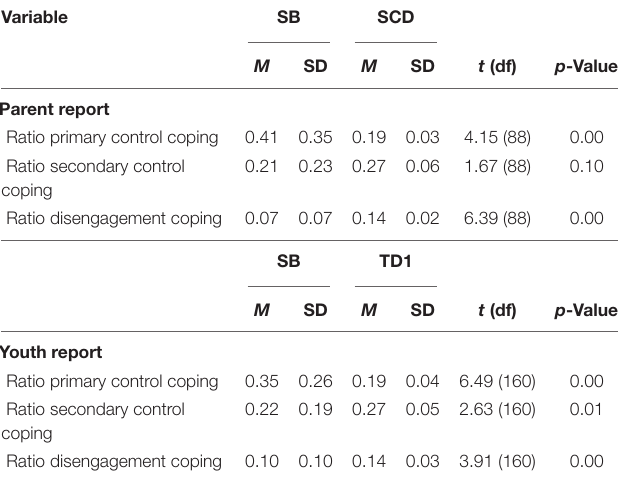
TABLE 3 | Parent- and youth-reported RSQ scores for youth with SB, SCD, and TD1.